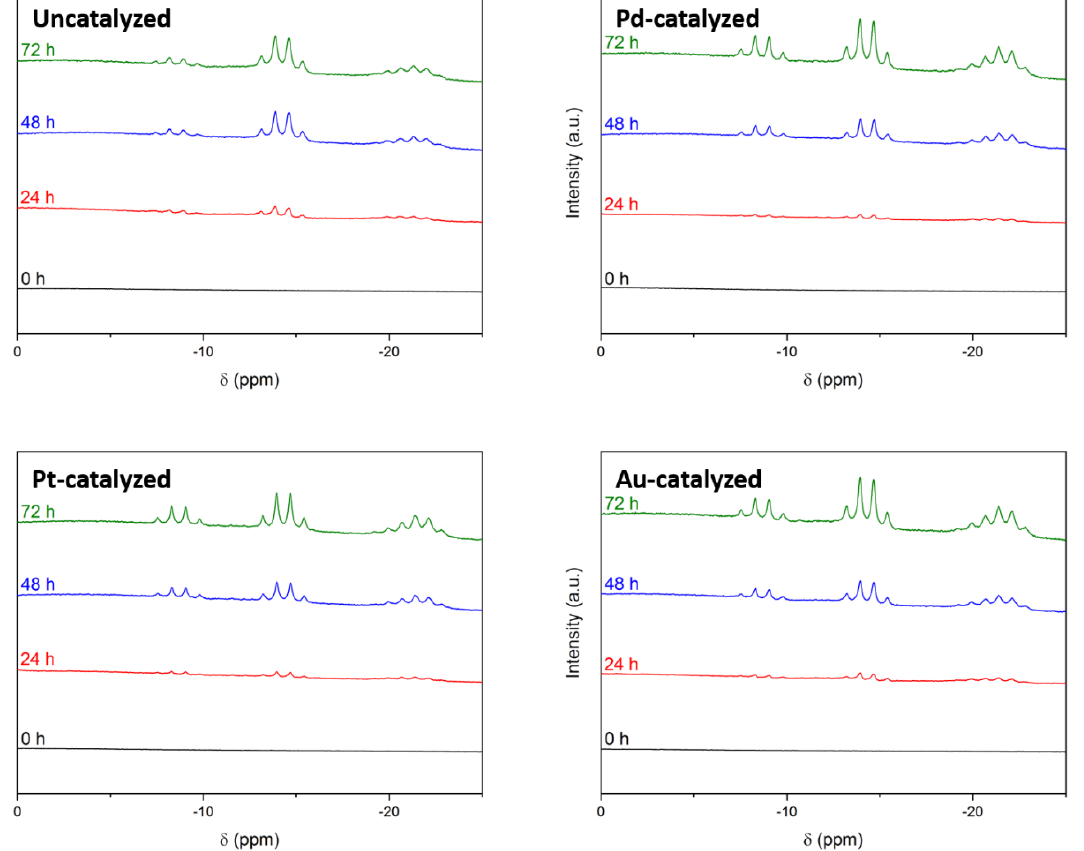
Figure 3. 11 B NMR spectra of the 10 mL DMF solutions of BH 4 − (1.32 M) hydrolyzed by 7.6 mL of alkaline (0.1 M NaOH), uncatalyzed or catalyzed by Pd, Pt, or Au after 0, 24, 48 and 72 h. These spectra focus on the range between δ 0 ppm and δ − 25 ppm to show the signals at δ < 0